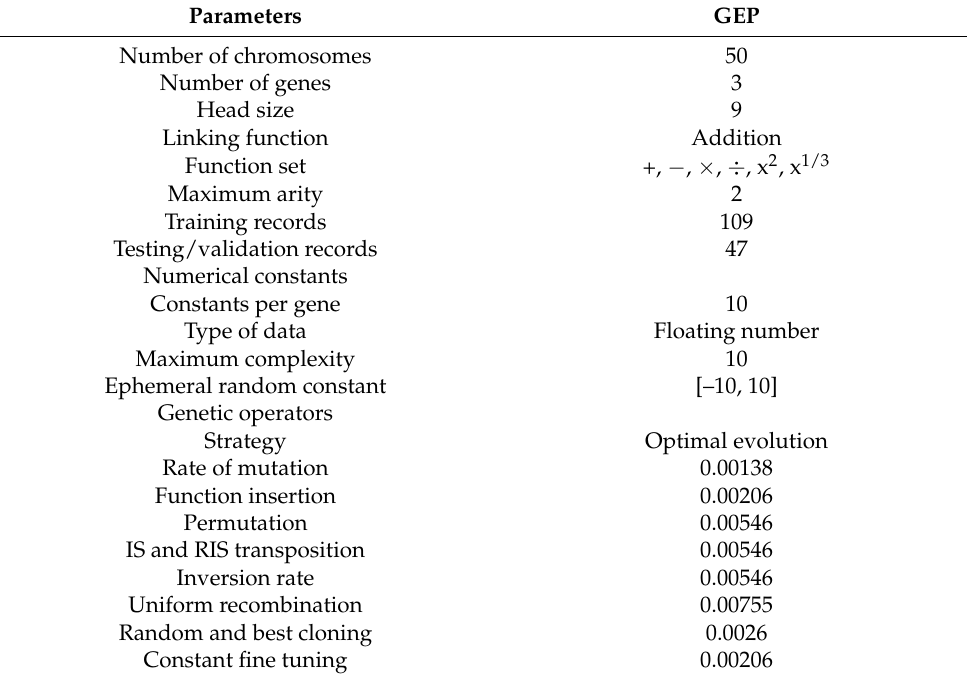
Table 6. Parameters setting for GEP algorithm (Trial 5) to determine CS 28d of waste PET/SCM blended cementitious